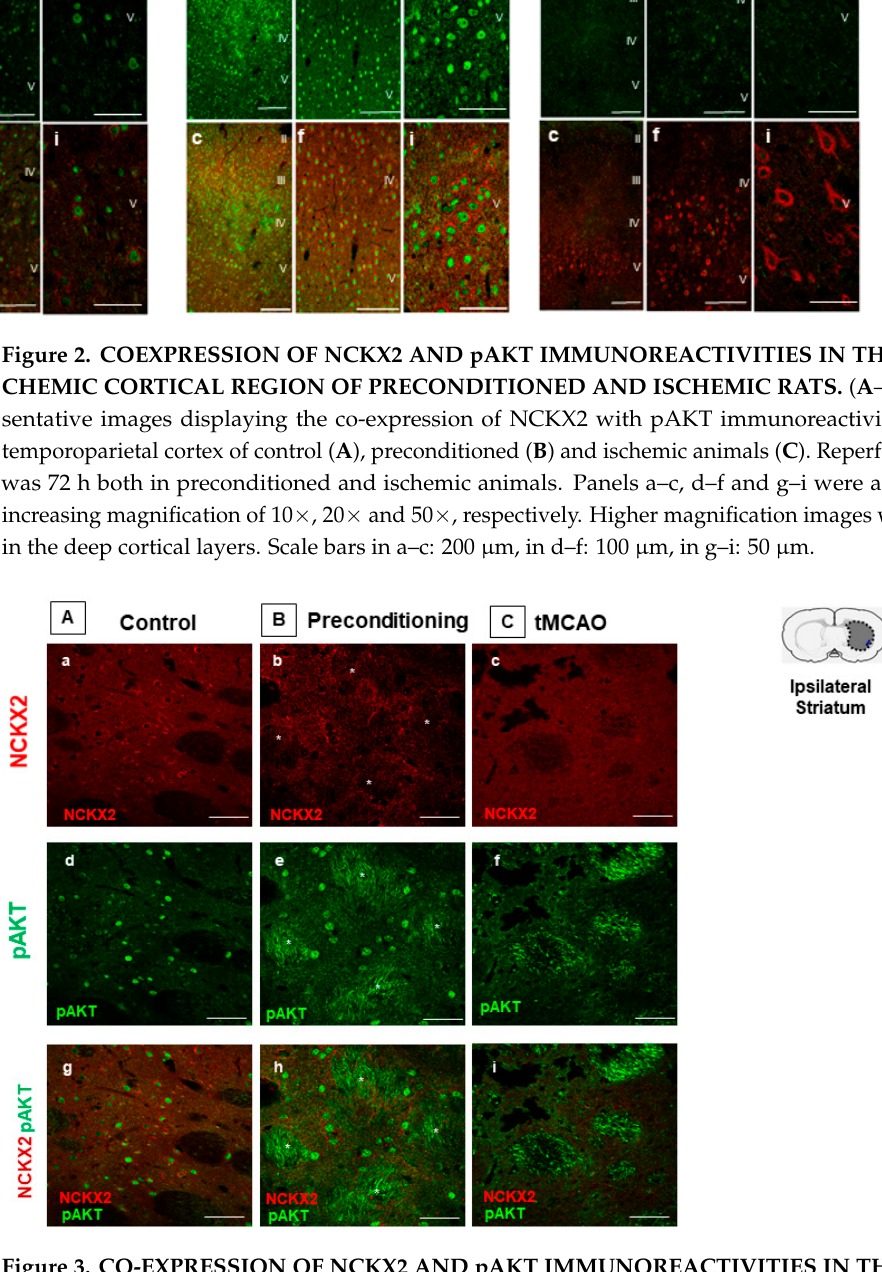
Figure 3. CO-EXPRESSION OF NCKX2 AND pAKT IMMUNOREACTIVITIES IN THE STRIA- TUM OF PRECONDITIONED AND ISCHEMIC RATS. Representative images (g–i) displaying the co-expression of NCKX2 (a–c) with pAKT (d–f) immunoreactivities in the striatum of control ( A ), preconditioned ( B ) and ischemic animals ( C ). Scale bars 50 µ m. 2.2. p-AKT Inhibitor LY294002 Prevents NCKX2 Overexpression Induced by Preconditioning in the Peri-Ischemic Temporoparietal Cortex To further support the tight interaction between NCKX2 and p-AKT, the p-AKT in- hibitor LY294002 was icv injected before preconditioning induction and NCKX2 expres- sion was evaluated in the ipsilesional temporoparietal cortex and in the striatum of rats exposed to ischemic preconditioning at 72 h of reperfusion and compared to the expres- sion of the protein in the same brain regions of vehicle-treated rats. In accordance with our results from double immunofluorescence experiments, showing a co-expression of NCX2 and pAKT in this brain region, the increase in NCKX2 protein expression induced by preconditioning in the temporoparietal cortex was prevented by the p-AKT inhibitor LY294002 (143 ± 8 vs. 117 ± 5.5, respectively) (Figure 4A), thus suggesting that NCKX2 overexpression induced by preconditioning in the cortex may occur through a p-AKT- mediated translational activation. By contrast, as expected, in the striatum, the use of LY294002 did not modify NCKX2 expression (Figure 4B), thus supporting the hypothesis that in this area and in these experimental conditions, NCKX2 synthesis did not increase, but rather it prevented its degradation promoted by the lethal ischemic insult. This result was in line with immunofluorescence experiments showing that after preconditioning, pAKT did not colocalize with NCKX2 in the striatum (Figure 3).